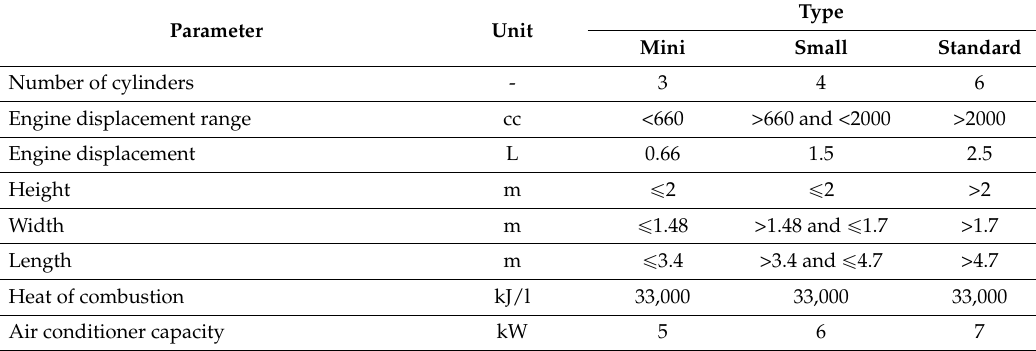
Figure 1. Energy flow diagram of an automobile engine. Table 1. Influence of operating the air conditioner on the performance of different types of vehicles